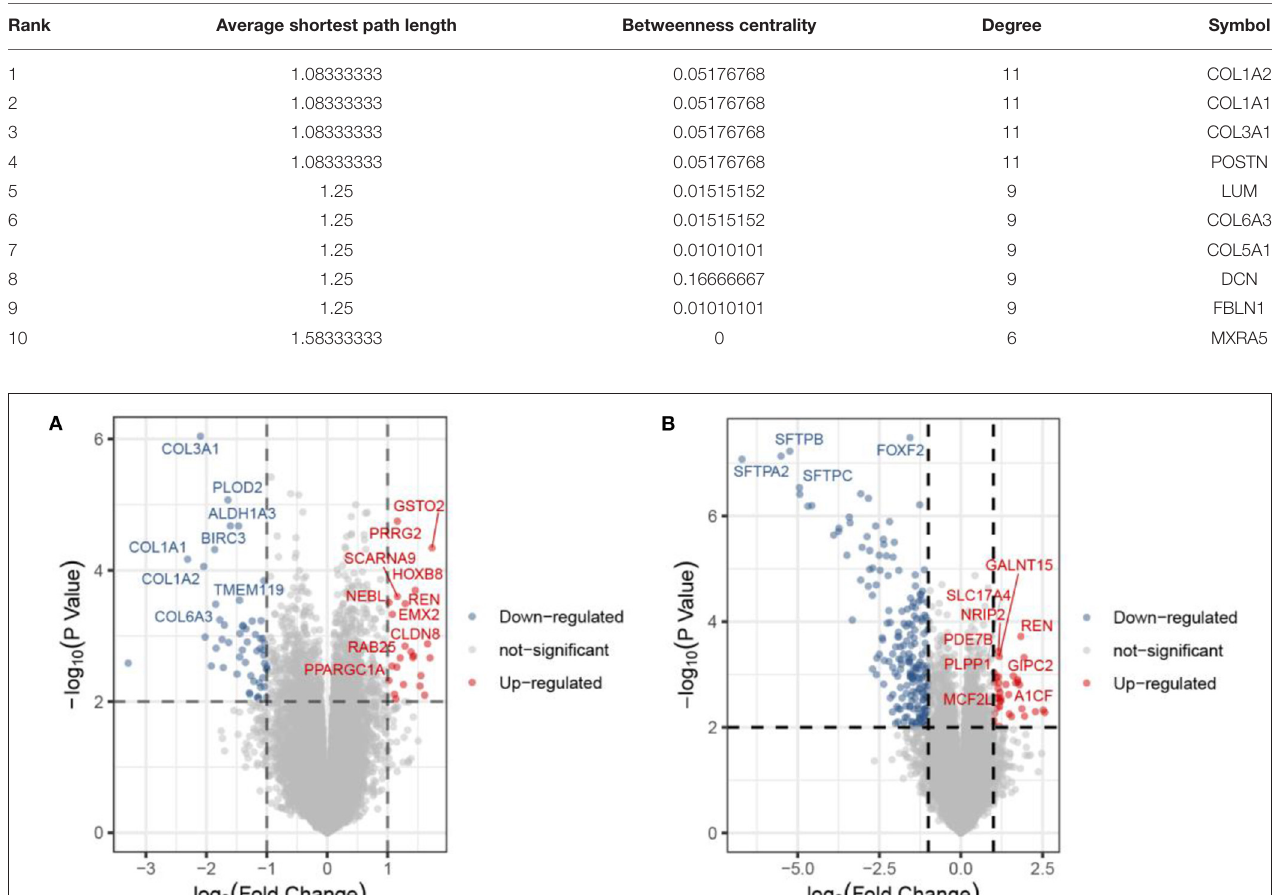
the potential GO classifications and KEGG pathway- enriched genes from the dataset. The results are presented in Supplementary Material 3 . The annotated results for the GO terms were divided according to the MF (molecular